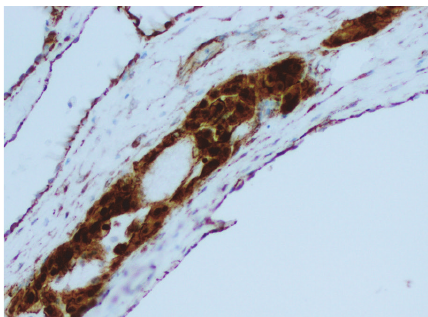
Figure 9: Beta-catenin with nuclear and cytoplasmic positivity in Leydig cells